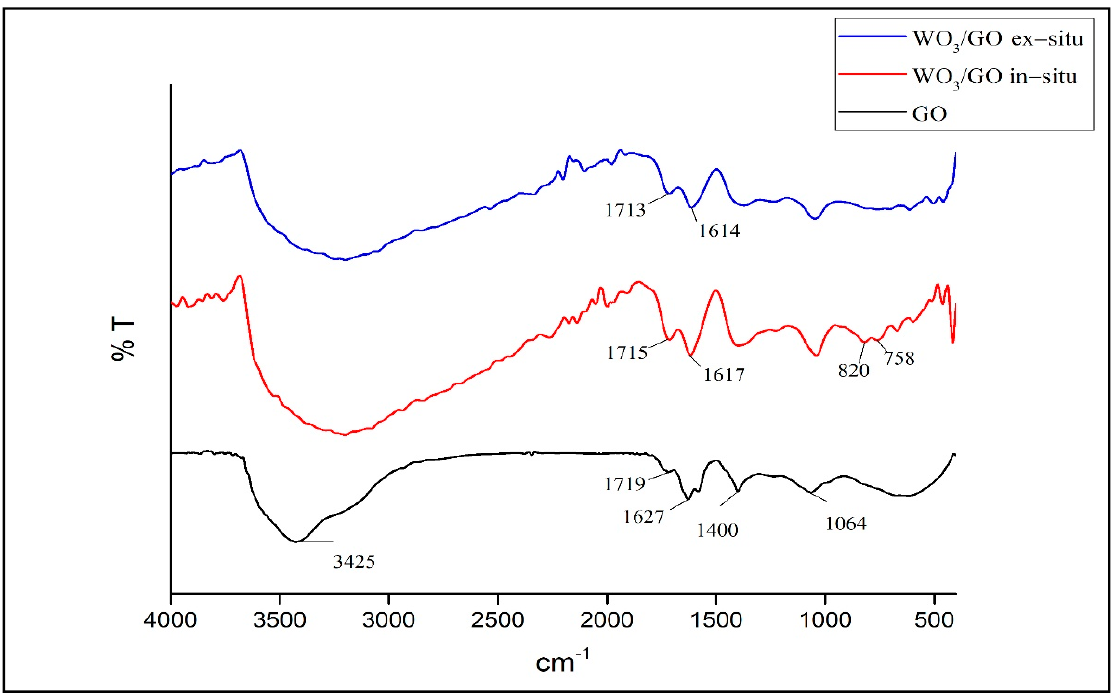
Figure 4. FTIR Spectra of GO and WO 3 /GO Composites.